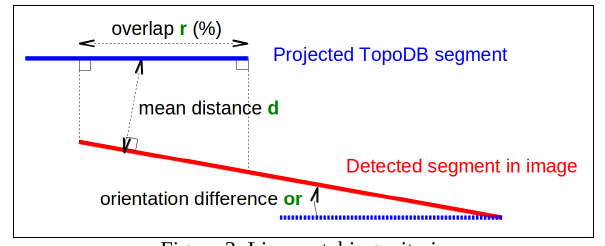
Figure 3. Line matching criteria